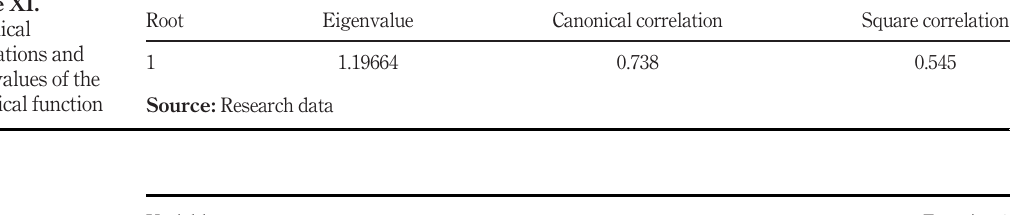
Table XII. Standardized canonical weights of the dependent variables for the fi rst canonical function